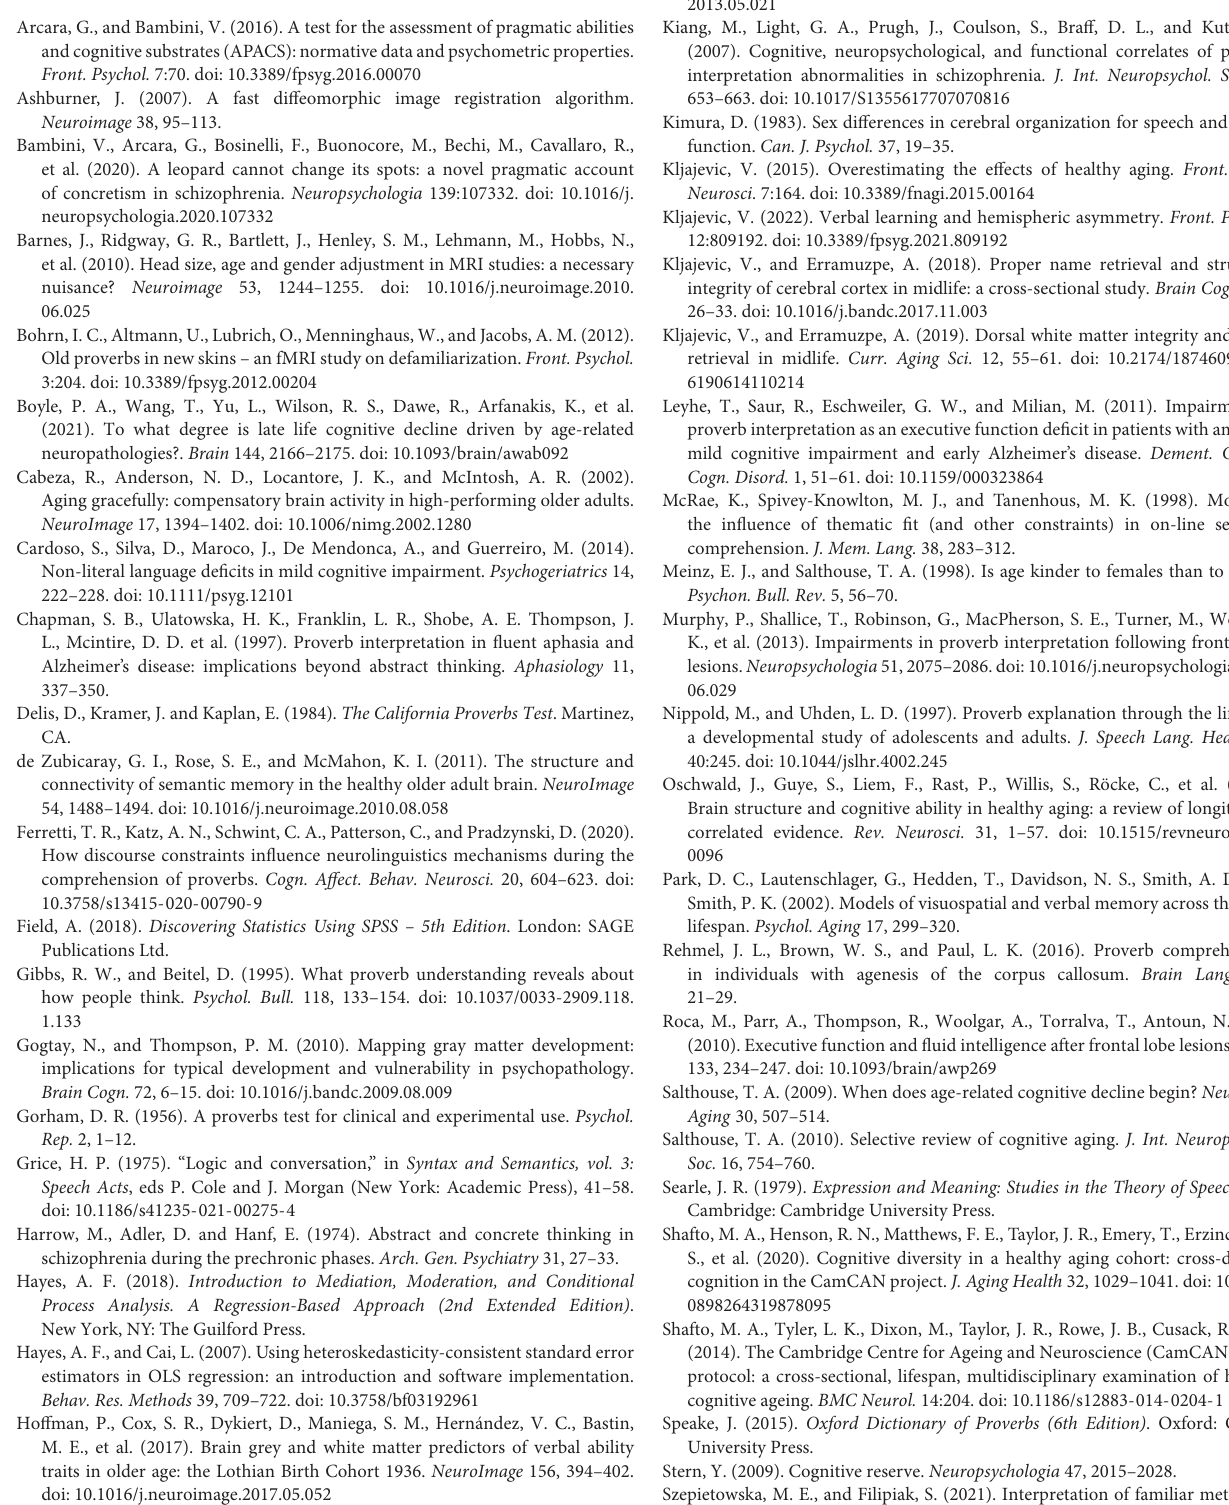
protocol: a cross-sectional, lifespan, multidisciplinary examination of healthy cognitive ageing. BMC Neurol. 14:204. doi: 10.1186/s12883-014-0204-1 Speake, J. (2015). Oxford Dictionary of Proverbs (6th Edition) . Oxford: Oxford University Press. Stern, Y. (2009). Cognitive reserve. Neuropsychologia 47, 2015–2028. Szepietowska, M. E., and Filipiak, S. (2021). Interpretation of familiar metaphors and proverbs by Polish people in middle and late adulthood. Int. J. Lang. Commun. Disord. 56, 841–857. doi: